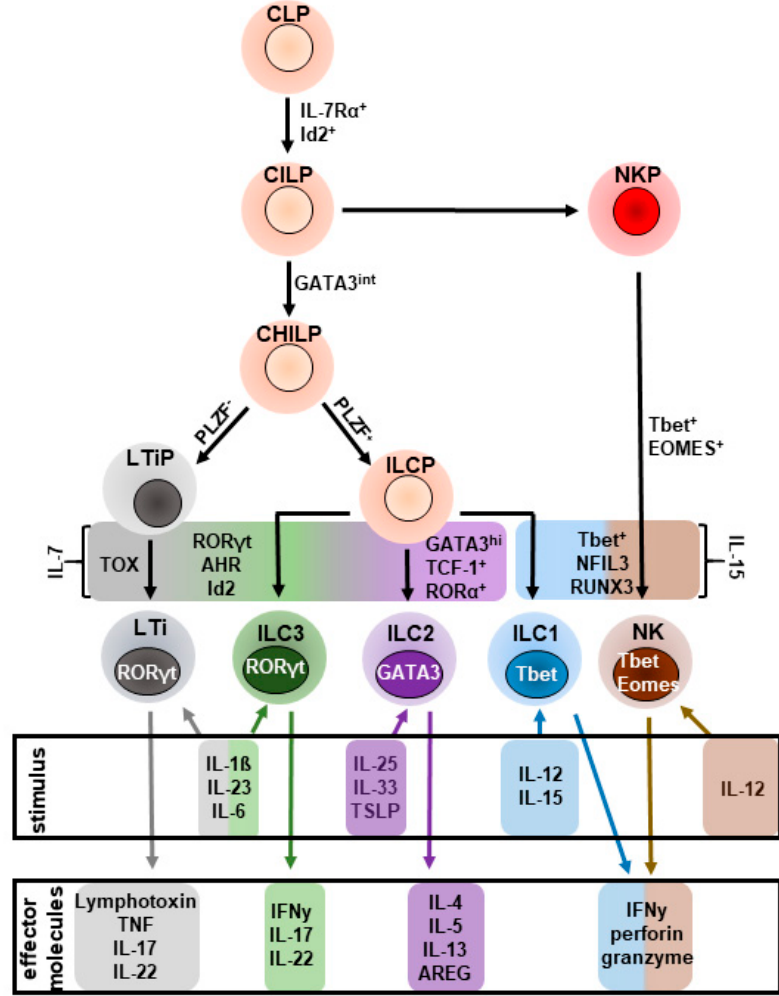
Figure 1. Schematic overview of helper innate lymphoid cell (ILC) development: All helper ILC subsets originate from an IL-7-responsive, inhibitor of DNA binding 2 (Id2) + common lymphoid progenitor (CLP) that further develops into a common innate lymphoid progenitor (CILP). CILP di ff erentiates into an NK cell precursor (NKP) or a common helper innate progenitor (CHILP) that transiently expresses GATA3. The subsequent transcriptional activity of promyelocytic zinc finger (PLZF) further promotes the CHILP to develop into innate lymphoid cell progenitors (ILCP) that di ff erentiate into ILC1-3, while PLZF − CHILP develops into a lymphoid tissue inducer progenitor (LTiP) that further matures into a lymphoid tissue inducer cell (LTi). ILC2-development from the ILCP further requires the expression of the transcription factors T cell factor 1 (TCF-1), RAR-related orphan receptor α (ROR α ), and GATA binding protein 3 (GATA3). AHR: Aryl hydrocarbon receptor; Eomesodermin; ROR γ t: RAR-related γ t; RUNX3: runt-related transcription factor 3; Tbet: T box transcription factor; TOX: Thymocyte selection-associated high mobility group box protein.